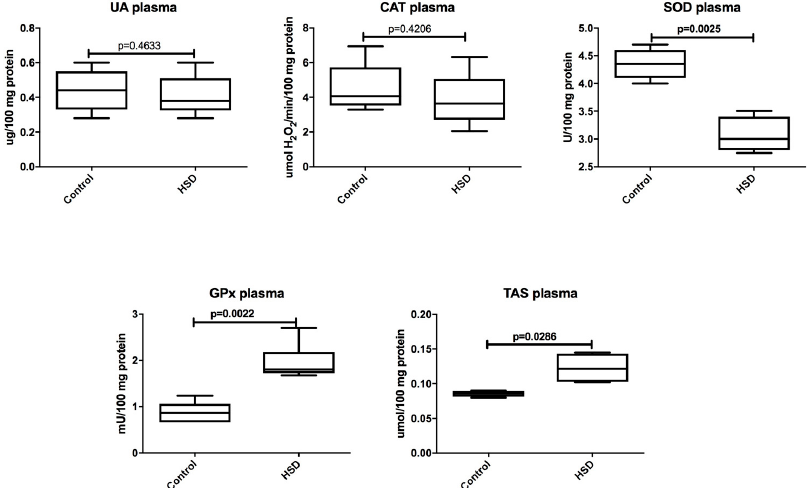
Figure 1. The effect of high-sucrose diet (HSD) on total protein, amylase activity, and non-stimulated and stimulated salivary flow rate. Abbreviations: HSD, high-sucrose diet, PG, parotid gland, SMG, submandibular gland.